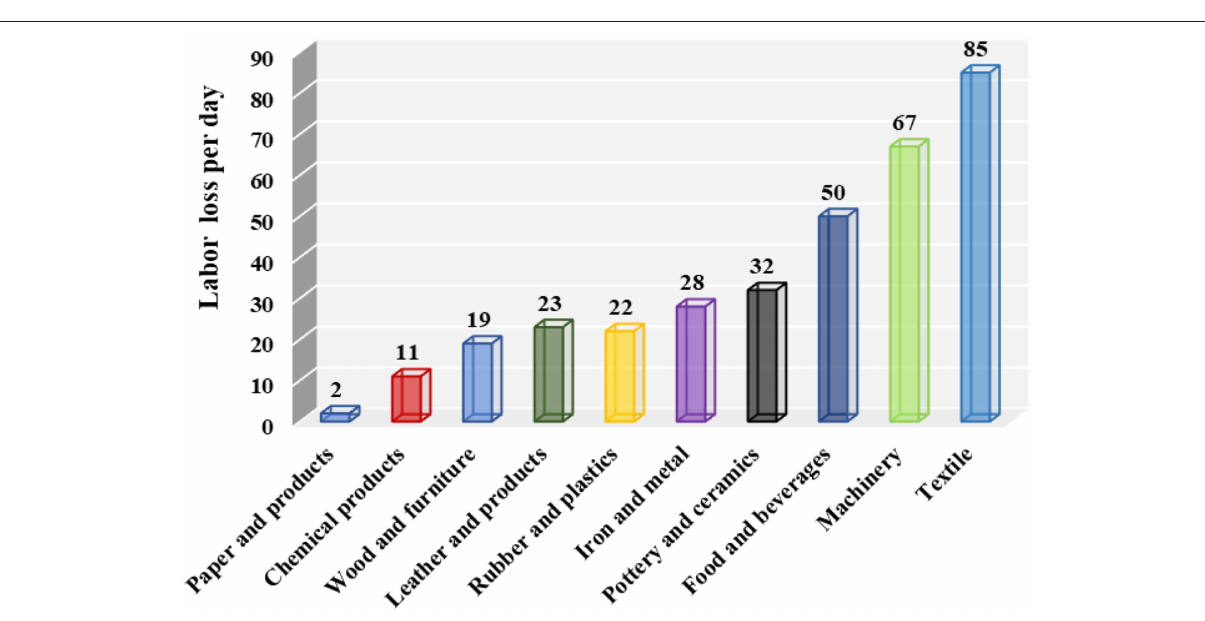
FIGURE 2 | Labor loss per day in different industries due to the energy